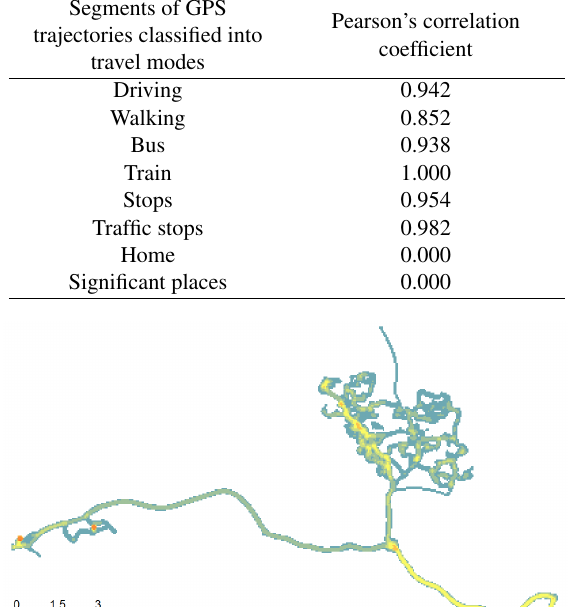
Figure 4: Spatial cloaking - GPS points inside the boundary cre- ated from 300-500 meters road network area around the signifi- cant locations (plus possible connection to the main road) to pre- serve privacy.